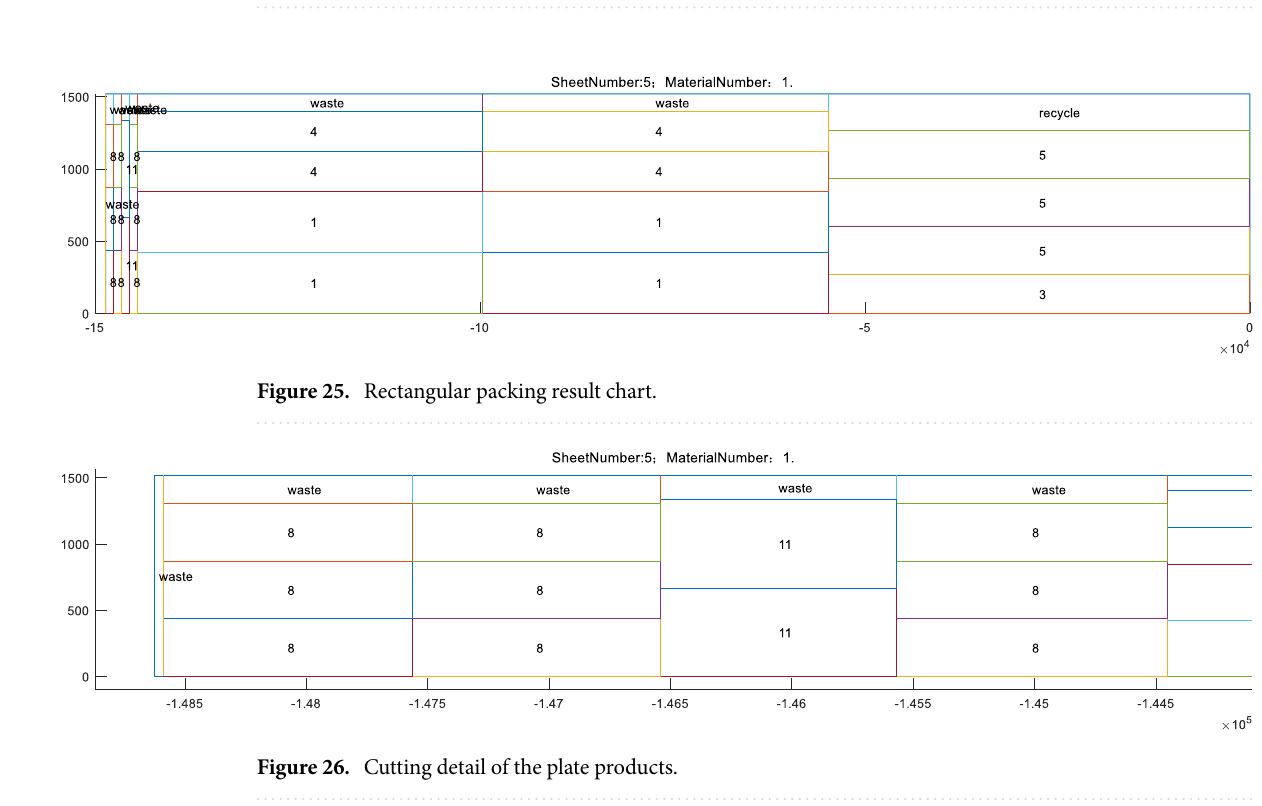
Table 5. Sample result.